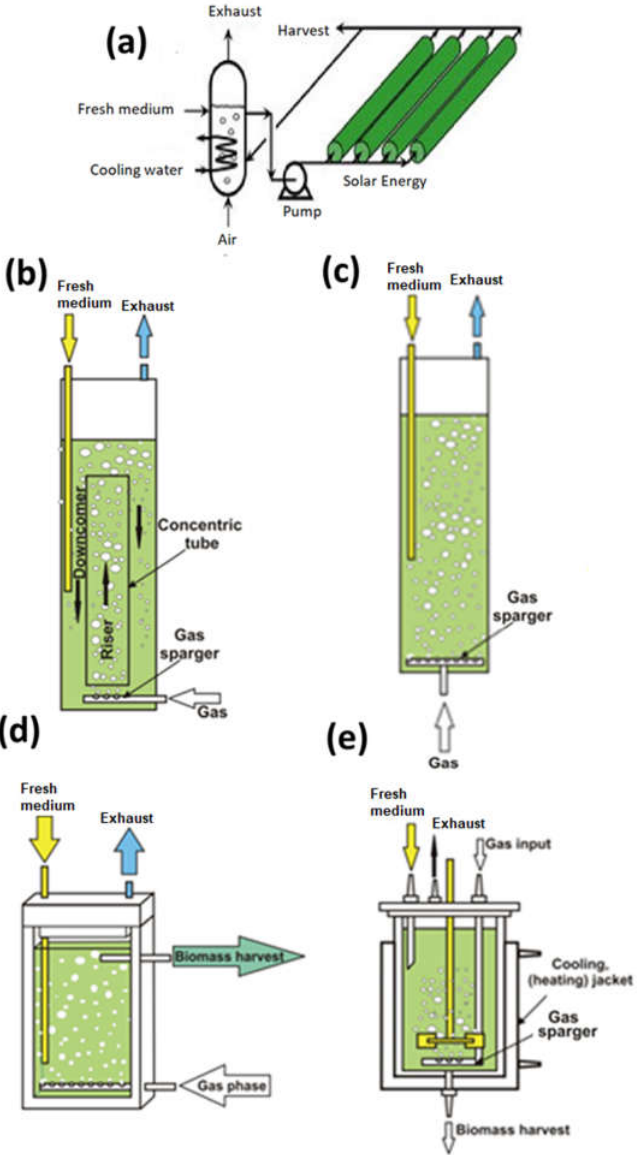
Figure 1. Schematic diagrams of main bioreactors ( a ) Tubular (Growing Algae, [32]), ( b ) Vertical Air-lift (Płaczek et al. [33]), ( c ) Bubble column (Płaczek et al. [33], ( d ) Flat panel (Płaczek et al. [33]), and ( e ) Stirred tank reactor (Płaczek et al. [33]).